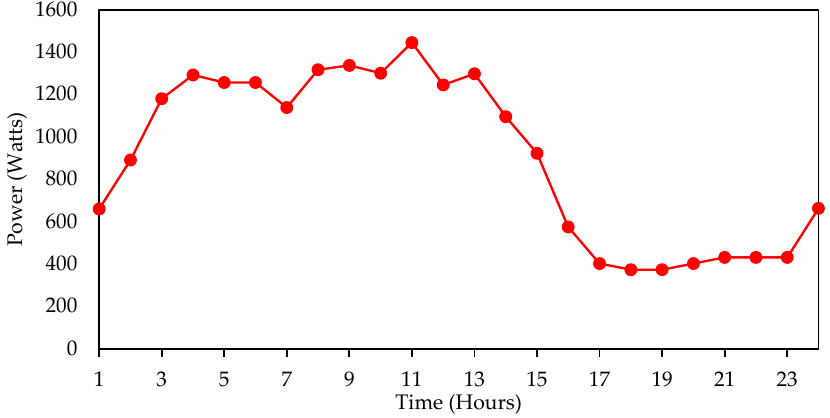
Figure 6. Demand curve of commercial load.